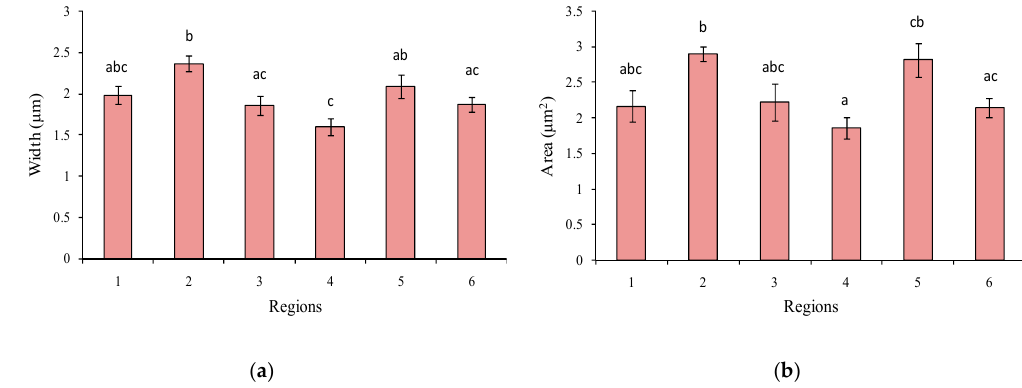
Figure 3. ( a ) Average width of scales according to the region of the skin they were extracted from (1 (operculum), 2 (dorsal), 3 (upper-peduncle), 4 (low-peduncle), 5 (anal), 6 (pectoral). Non-coincident letters among regions indicate statistically significant differences according to a Tukey’s test ( n = 5, p < 0.05); ( b ) Average size of the area of scales according to the region of the skin they were extracted from. The letter code indicates significance as previously described ( n = 5, p < 0.05).